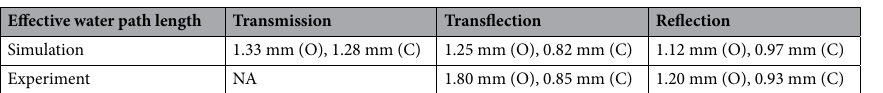
Effective water path